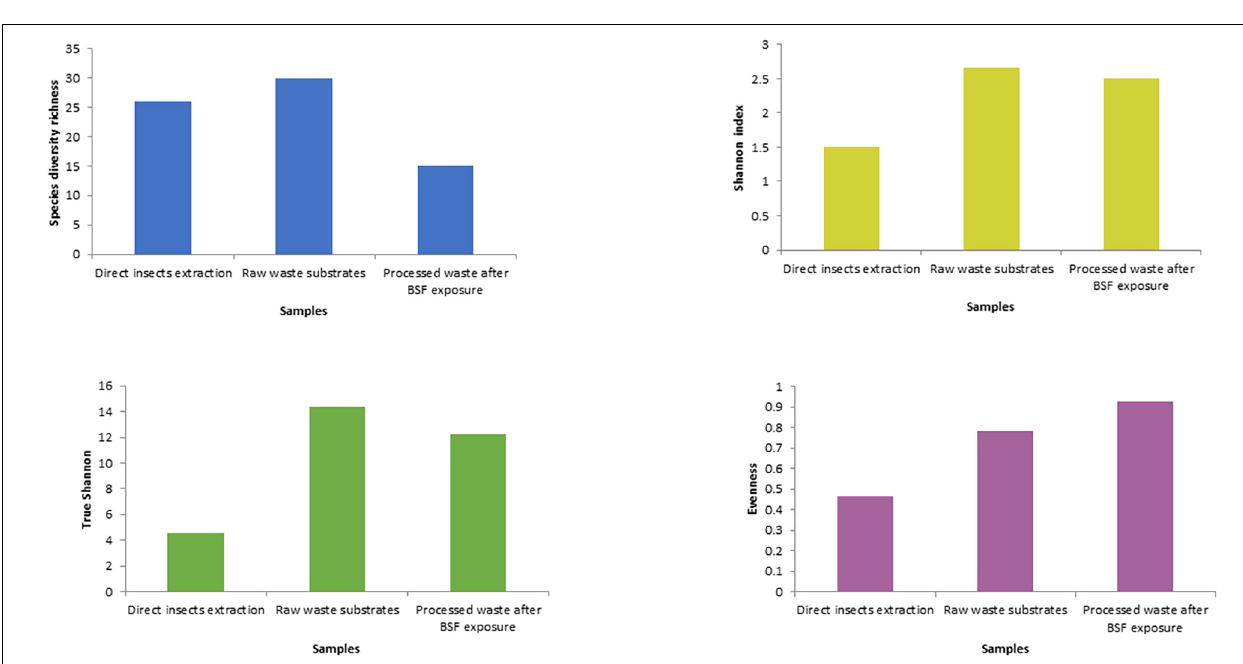
FIGURE 5 | Alpha-diversity measures using evenness, Shannon diversity index, and species richness at the genus level in the black soldier fly larvae (BSFL) and its substrates. The samples were composed grouped into three pooled categories (insects’ extraction, raw waste substrates, and the BSF frass) and are represented on the X -axis, and their estimated diversity is represented on the Y